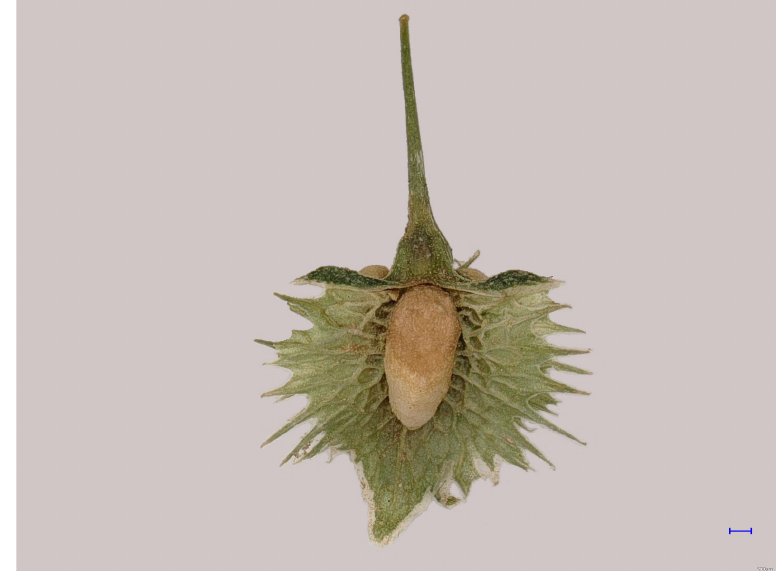
Figure 2. Detail of fruiting valves of Rumex chalepensis . Characteristic are the three well-developed tubercles, four or more teeth on either side of the valve, the broadly rounded outline of the valves, their distinct venation and the dilated pedicel just below